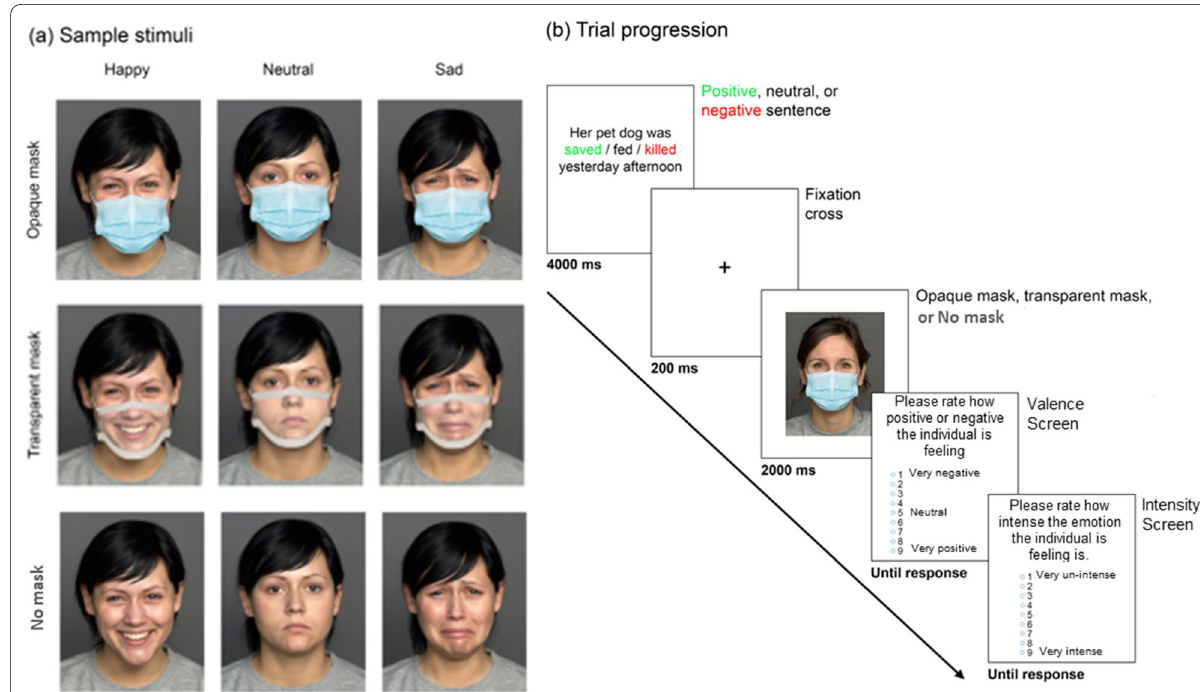
Fig. 1 a Example photographs depicting happy, neutral, and sad expressions for Opaque mask, Transparent mask, and No mask conditions; b Sample trial progression. Participants were presented with a contextual sentence for 4000 ms. A fixation cross in duration of 200 ms preceded the presentation of a stimulus photograph displaying a congruent emotion while wearing an opaque mask, a transparent mask, or no mask. The face stimulus was shown for 2000 ms. Affective theory of mind responses were collected by asking participants to rate, on a scale from 1 (negative/low) to 9 (positive/high), how positive or negative the protagonist was feeling and the intensity of their emotion. Each response screen remained visible until